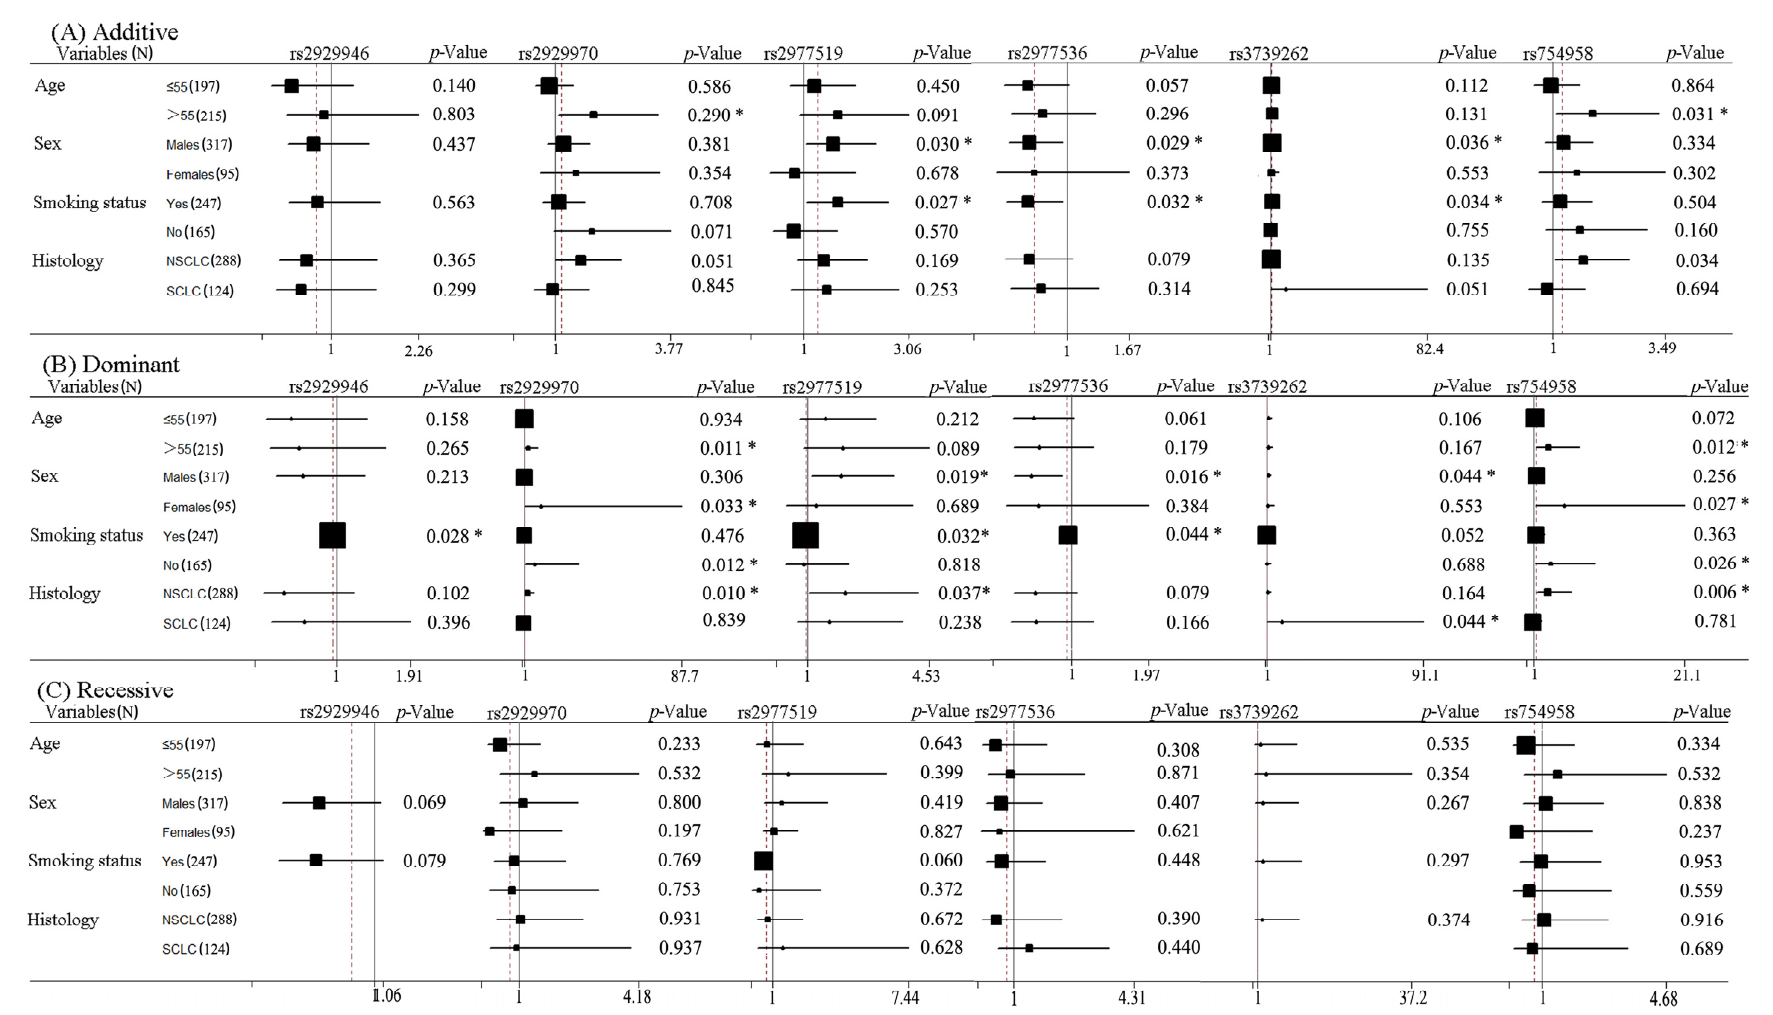
Figure 3. Stratification analyses of the associations of WISP1 rs2929946, rs2929970, rs2977519, rs2977536, rs3739262 and rs754958 polymorphisms with the gastrointestinal toxicity of lung cancer. Each box and horizontal line represents the values of OR and 95% CI. NSCLC, non-small cell lung carcinoma; SCLC, small cell lung carcinoma. * p <